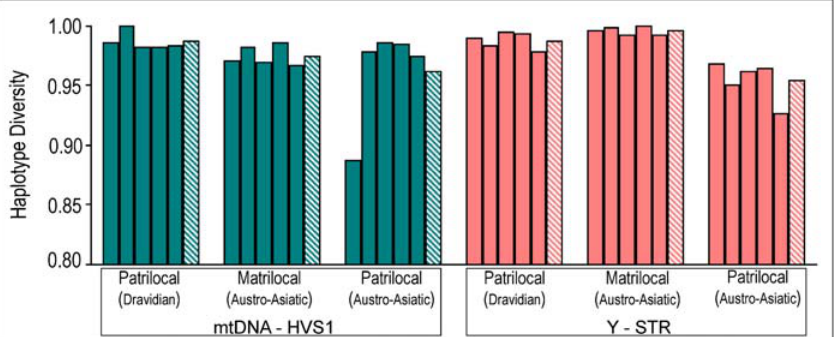
Figure 2. Haplotype Diversity in mtDNA (Green) and Y-STR (Pink) and Their Mean (Shaded Bar) in Five Dravidian and Five Austro-Asiatic Patrilocal and Five Austro-Asiatic Matrilocal Populations From left to right, the Dravidian patrilocal groups (mtDNA sample size and Y-STR sample size) are Akhutota (32, 21), Kapu (22,16), Panta (37, 21), Pokanati (59, 25), and Vanne (32, 23); the Austro-Asiatic matrilocal groups are Maram (72, 58), Khynriam (95, 82), Pnar (69, 40), Bhoi (34, 30), and WarKhasi (31, 23); the Austro-Asiatic patrilocal groups are Asur (30, 28), Bhumij (40, 39), Kharia (21, 13), Munda (23, 23), and Santhal (39, 38). DOI: 10.1371/journal.pgen.0020053.g002